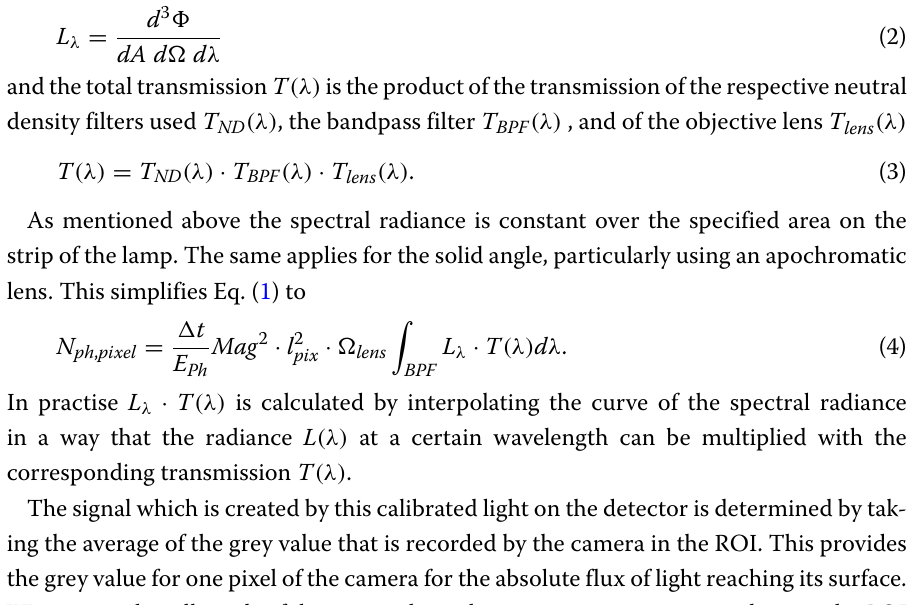
through the various optical components, and (cid:3) lens the solid angle accepted by the lens. The spectral radiance is given